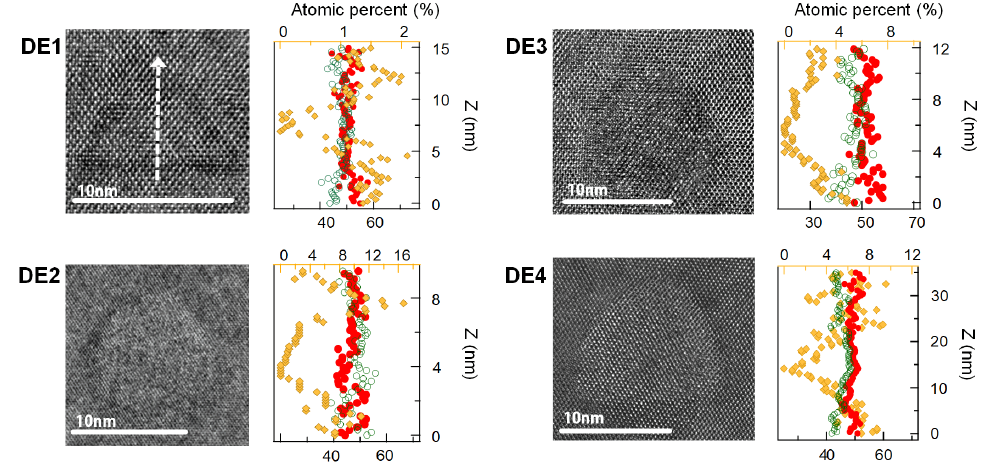
Figure 2. High-angle annular resolution dark-field-TEM images (gray) of the four GaAs DE QD species studied and the corresponding line concentration profiles of Ga (green open circles), As (red circles), and Al (yellow diamonds) obtained by EDS. The white arrow in the TEM image of DE1 represents the elemental line scan across the central region of each QD. The EDS data provide the relative amounts of atomic elements, and the experimental compositional errors for Ga and As were 1.4% and 2.3%, respectively, with corresponding standard deviations of 1.0% and 1.8%. The atomic percentage of Al is indicated along the top (yellow) axis and those of Ga and As are represented along the bottom